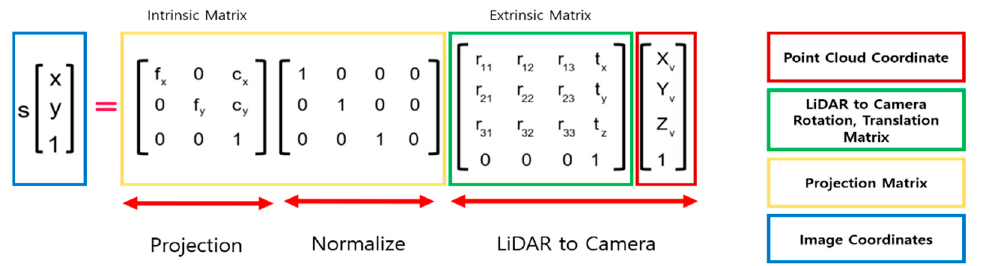
Figure 4. Point cloud 2D projection.